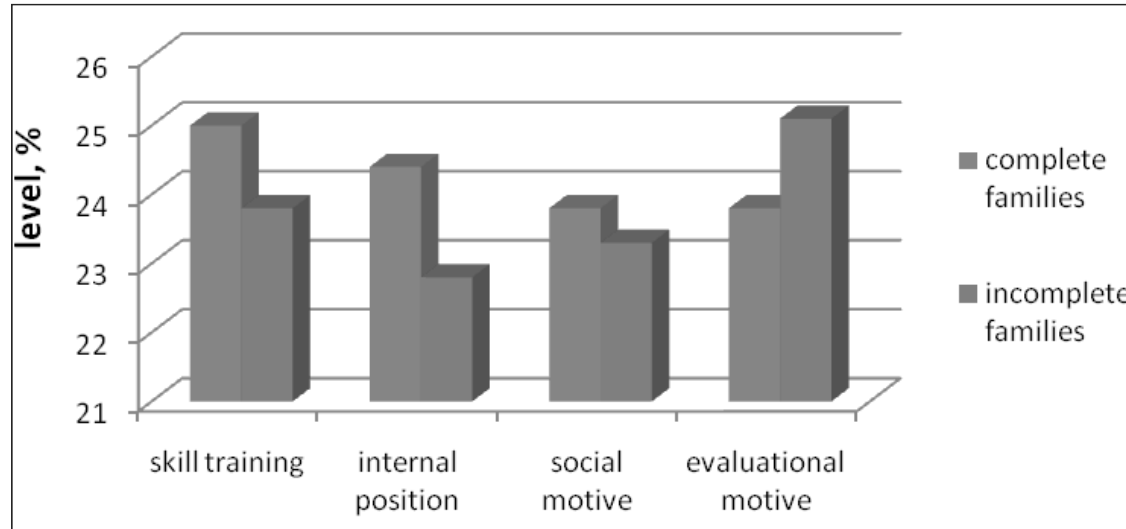
Figure 5. .Results of comparative analysis for children from nuclear and single parent